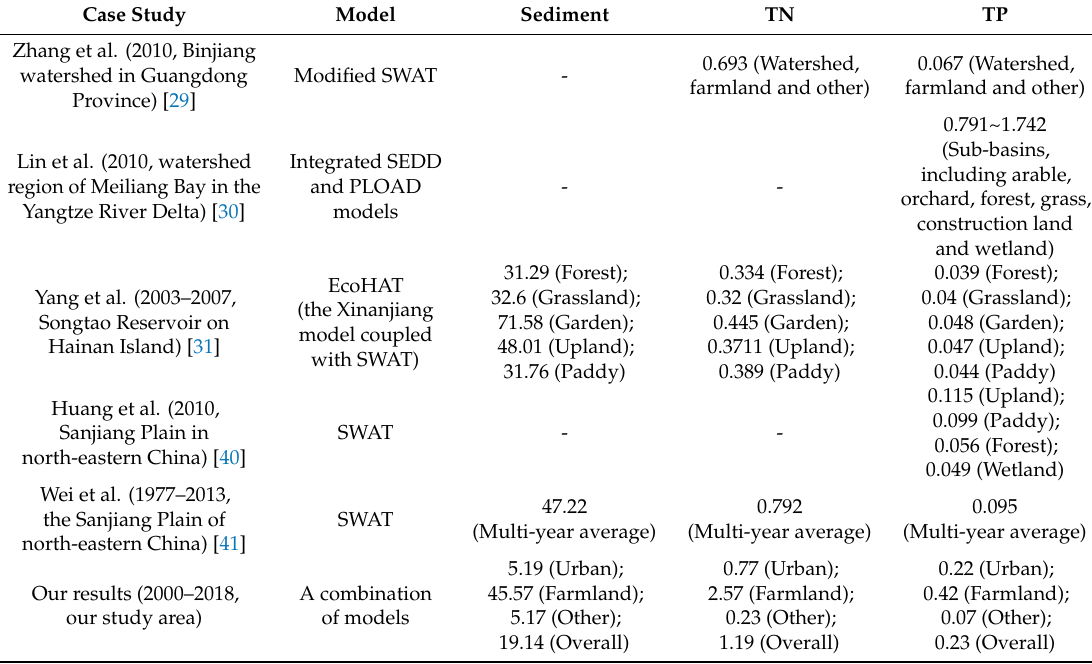
Table 8. Some similar case studies in China with the simulated sediment and NPS pollution production per unit area (unit: tons km − 2 year − 1 ).